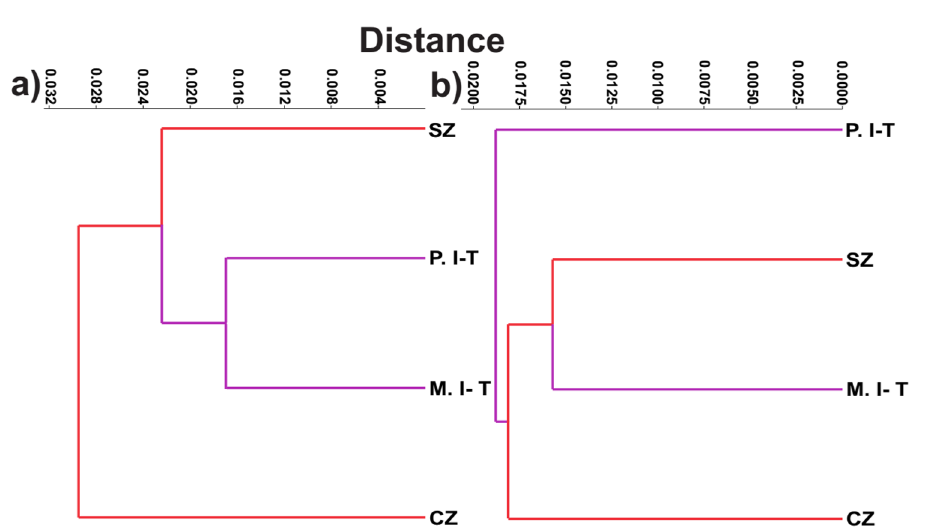
Figure 10. Cluster dendrogram of T. graeca populations in Central Iran, based on carapace ( a ) and plastron ( b ) shape